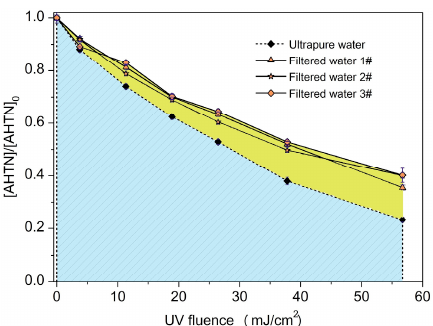
Figure 8. Degradation of AHTN by UV/FC under conditions relevant to tap water ([AHTN] 0 = 1.0 mg · L − 1 ; pH = 7.0; 25 ± 1 ◦ C; and [FC] 0 = 3.28 mg · L − 1 ). Table 1. Water quality of the waters collected from filtered water (FW). Table 3. Pseudo-first-order rate constants for AHTN degradation by UV/FC under various conditions. Varying